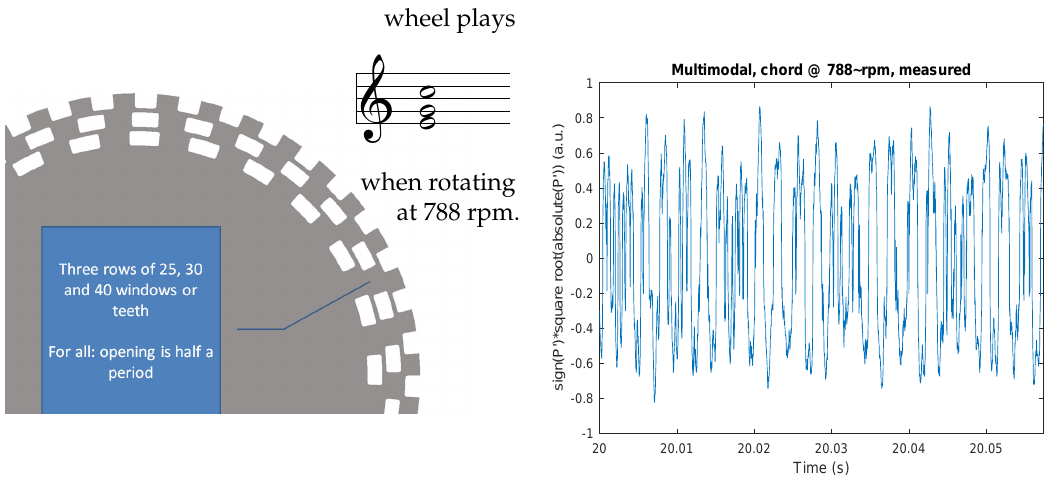
Figure 8. The multimodal wheel, designed to generate a synthetic signal reproducing a major chord, and measured chord